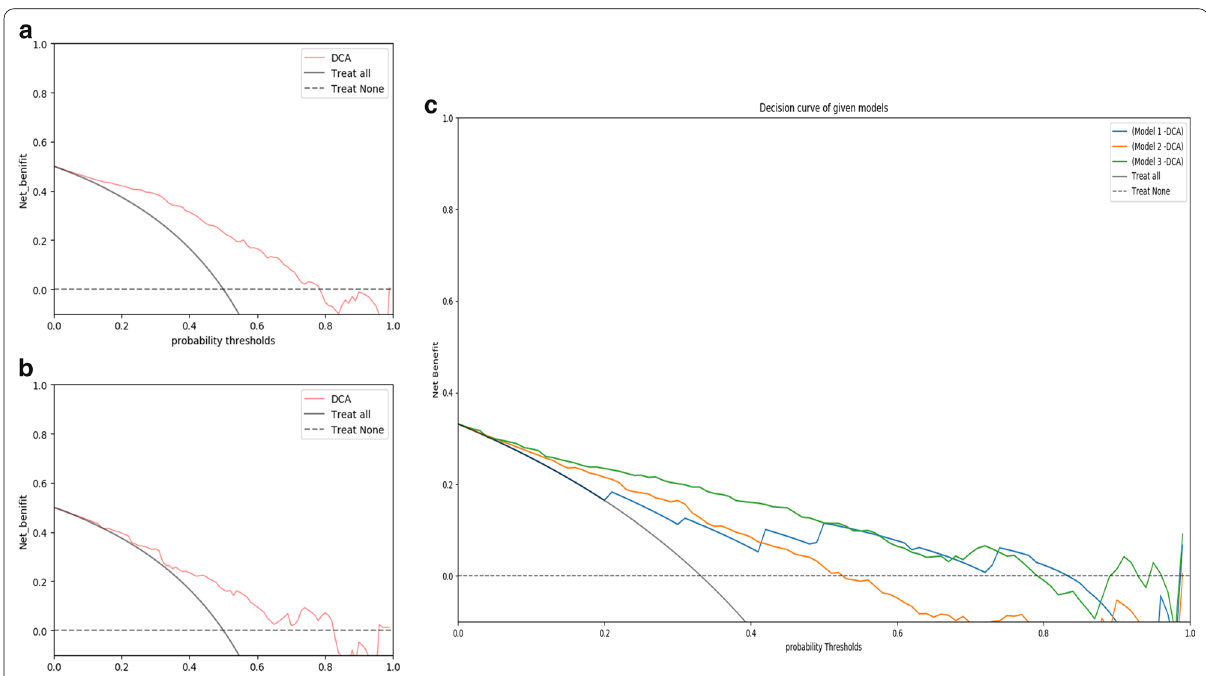
Fig. 5 Decision curves analyses (DCA) across all threshold probabilities. The DCA plots the model’s net benefit (y-axis) against threshold probability (x-axis) for predicting MTHCC in the entire patients. The “treat all line” assumes all lesions are MTHCC, and the “treat none” line assumes all lesions are non-MTHCC. The DCA of model 1 in training ( a ) and validation sets ( b ); the curve has a higher net benefit than treat-all strategies at a low threshold probability of 10%; ( c ) the decision curve comparison between models 1 (blue), 2 (red), and 3 (green) for all